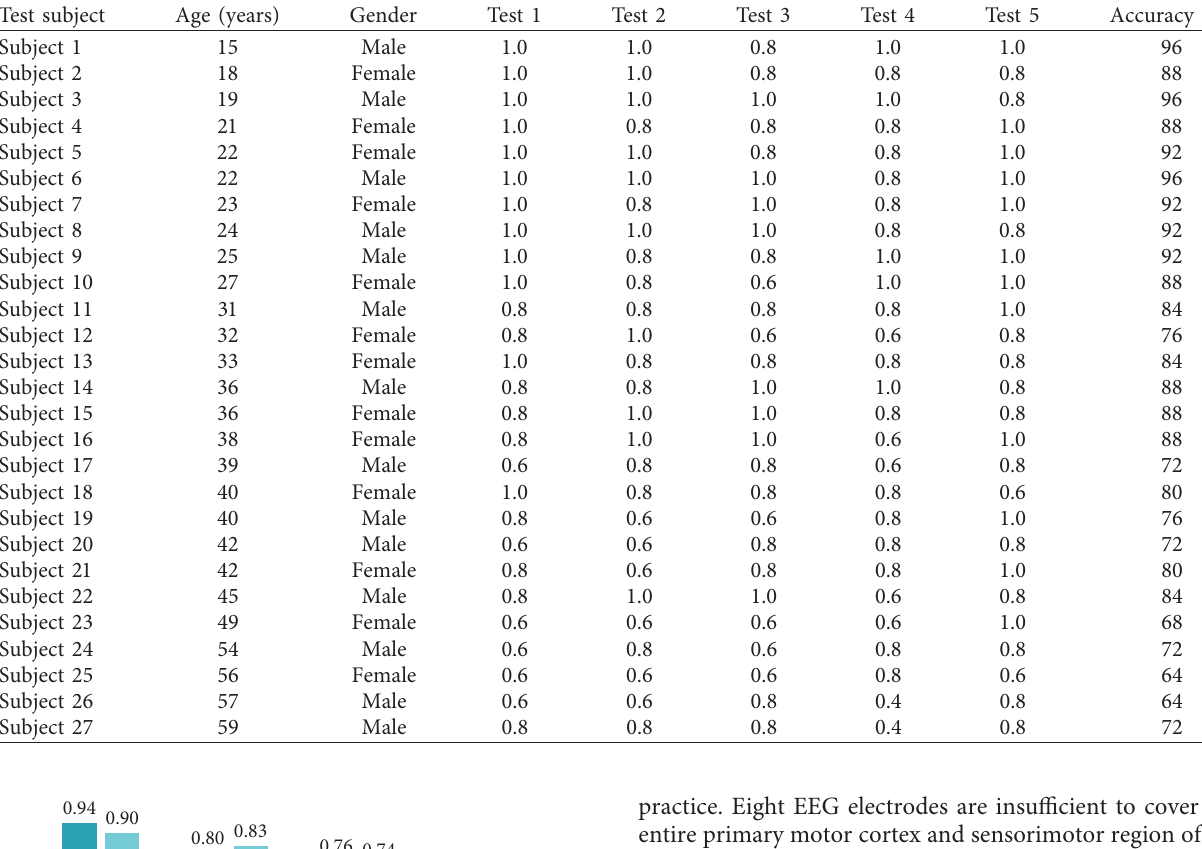
Table 8: Experimental results of the test subjects.